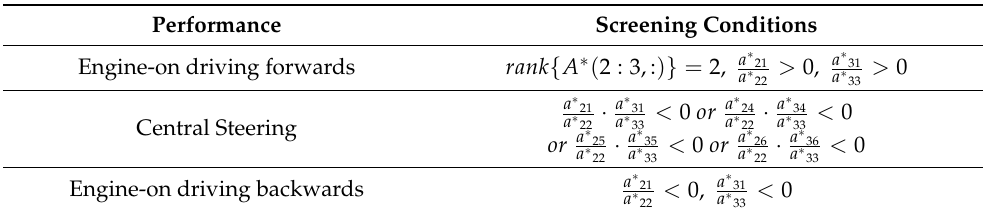
Table 3. Attribute screening conditions.